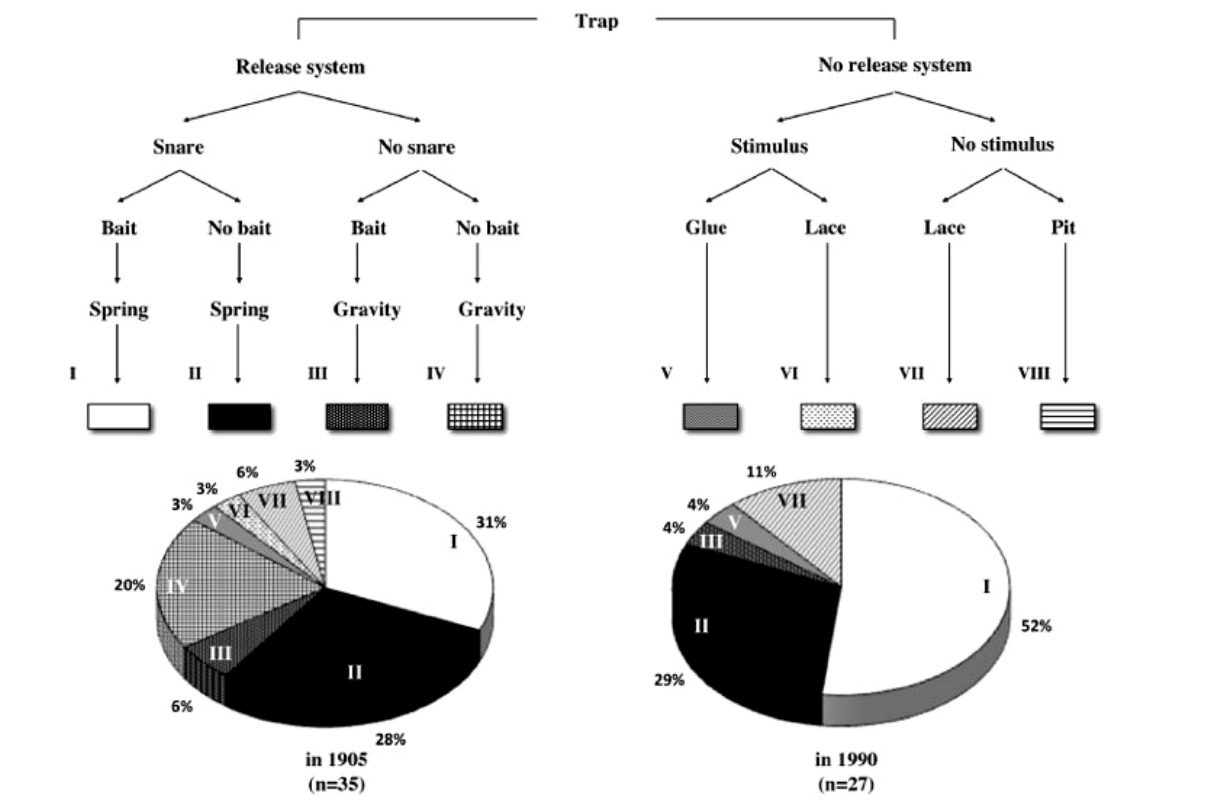
Fig. 9 . Compared mechanical typology of traps between 1905 and